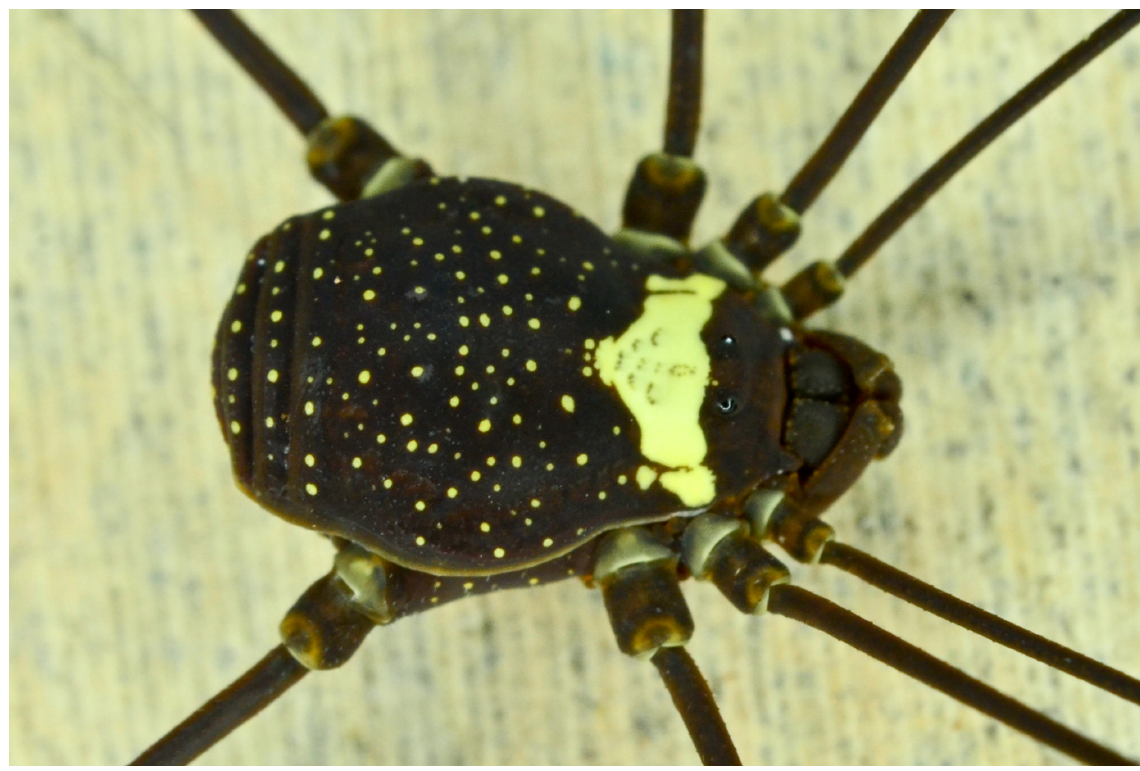
Fig. 13. Living specimen of Paecilaemella multimaculata (Wood, 1869) (CHNUFP) from Cruzeiro do Sul, Acre (photo courtesy of Leonardo